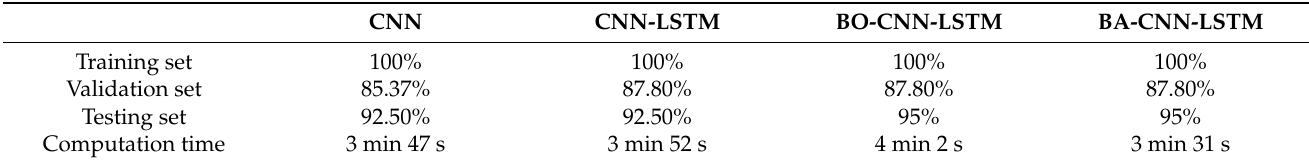
Table 9. The classification accuracy and time (ECG